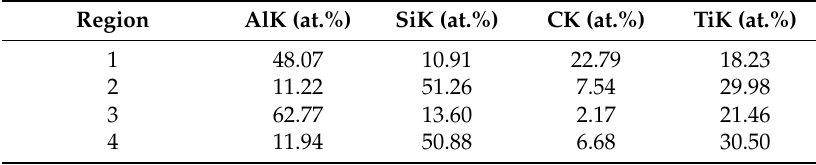
Table 3. EDS analysis results of different inner regions shown in Figure 3. Region AlK (at.%) SiK (at.%) CK